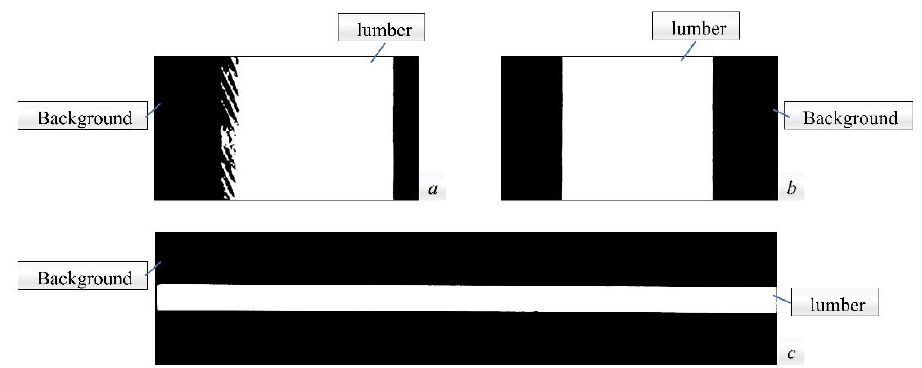
Figure 4. The image of threshold segmentation by applying the automatic adjusting light source device. ( a ) The image of threshold segmentation before applying the automatic adjusting light source device; ( b ) The image of threshold segmentation through applying the automatic adjusting light source device; ( c ) The lumber and background segmentation.